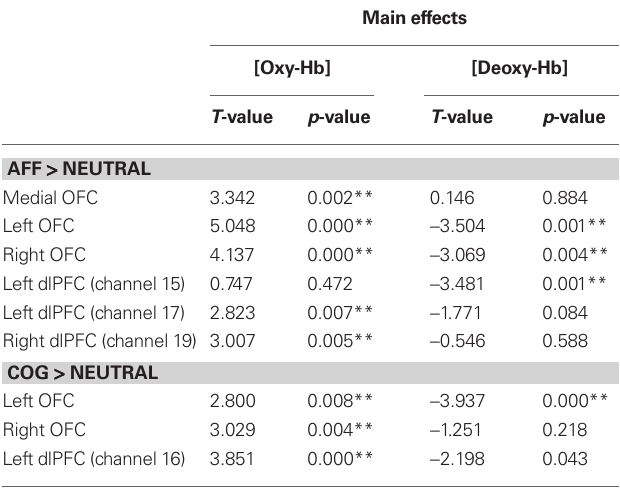
Table 2 | Significant findings for non-verbal cartoon stories.